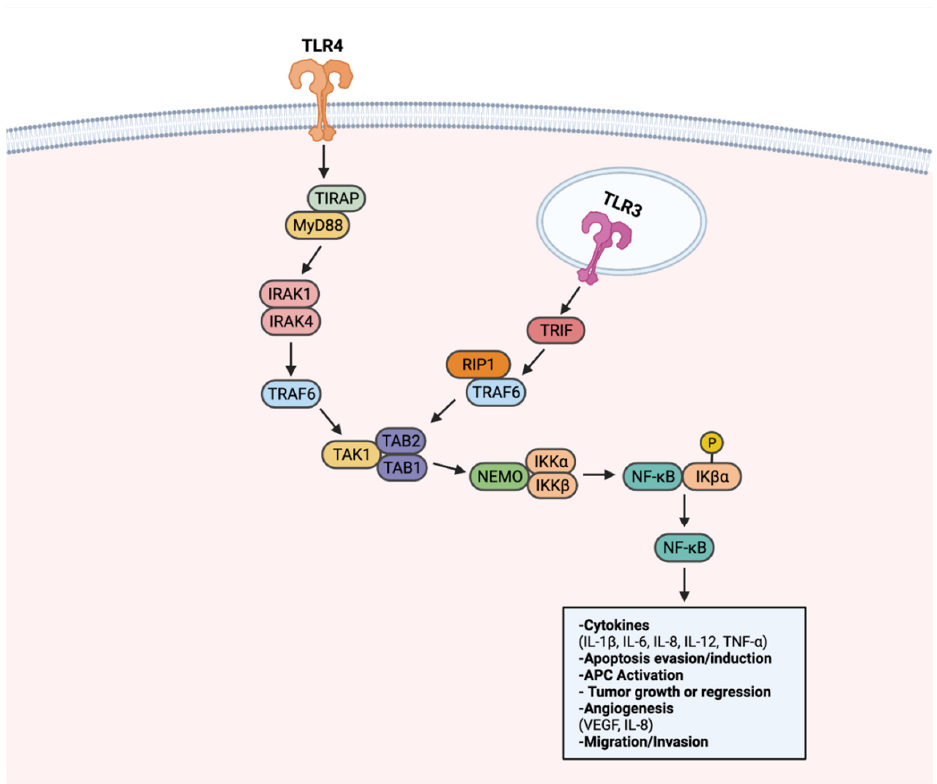
Figure 2. TLR-NF- κ B signaling in progression or regression of cancer. Upon recognition of a ligand, TLRs transduce signals through a MyD88-dependent signaling pathway, or alternatively a MyD88- independent TRIF-activating pathway. Upon activation of the MyD88-dependent pathway, adapter molecule TIRAP transduces signals to MyD88. MyD88 activates IRAK1 and IRAK4. Activated IRAK1 and IRAK4 lead to activation of TRAF6. TRAF6 activates the TAK1 complex. The TAK1 com- plex activates the IKK complex comprised of NEMO, IKK α , and IKK β . IKK complex activation leads to phosphorylation of IK βα , a protein responsible for sequestering NF- κ B to the cytoplasm. Once activated, NF- κ B translocates to the nucleus to activate genes that can promote or inhibit tumor- igenesis. NF-kB also can be activated through TRIF, notably through TLR3. TRIF activation results in RIP1 and TRAF6 activation. Through RIP1 and TRAF6, the TAK1 complex is activated. Following TAK1 complex activation, subsequent steps in NF- κ B signaling are shared between the two path- ways. Created with Biorender.com. Tumorigenic TLR signaling extends beyond the canonical NF- κ B pathway. Adaptor protein BCAP has been recognized as a link to TLR activation and downstream PI3k-Akt signaling [136,137]. PI3K-Akt signaling regulates cell proliferation, cell growth, and sur- vival, thus is frequently upregulated in many cancers [138] (Figure 3). TLR7 activation was found to perpetuate pancreatic cancer progression through upregulated PI3K/Akt signaling. Consequently, an upregulation of downstream signaling targets was also ob- served, including antiapoptotic and pro-proliferative genes Bcl-xL and c-Myc [64,134]. Apoptosis resistance in PCI-30 cells has been shown to be mediated by TLR4-PI3K/Akt signaling [135]. Enhanced angiogenesis has also been described as a product of PI3K-Akt signaling, particularly in a cancer context. TLR4 stimulation in PANC-1 cells has increased vasculature formation and proliferation through PI3K/Akt dependent signaling [138].